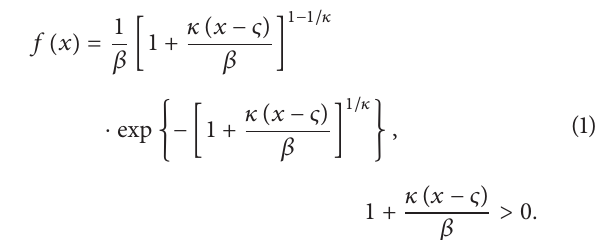
Figure 1: Regions and observation stations